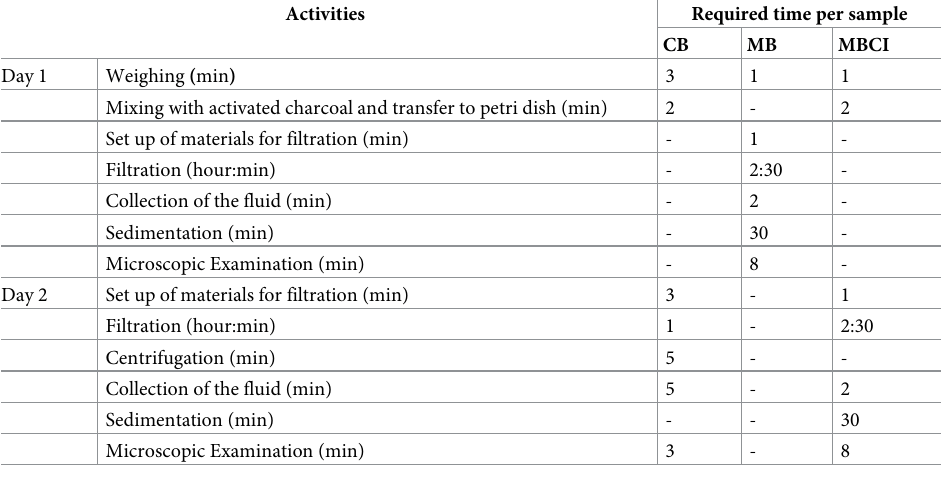
Table 3. Time required to process three Baermann